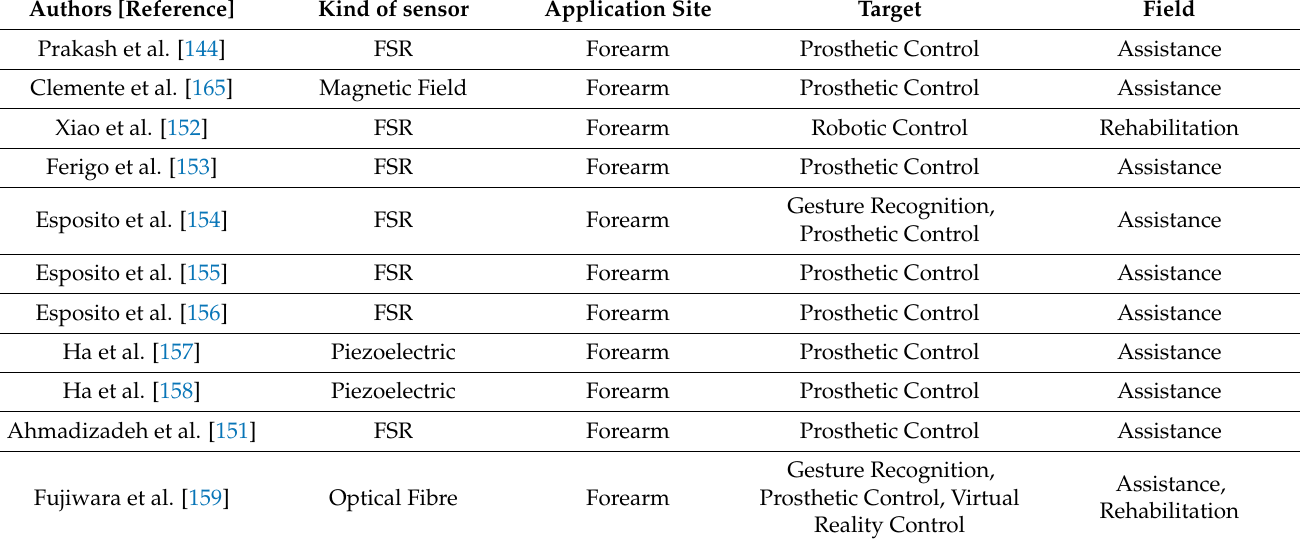
Table 7. Muscle gross motion-based